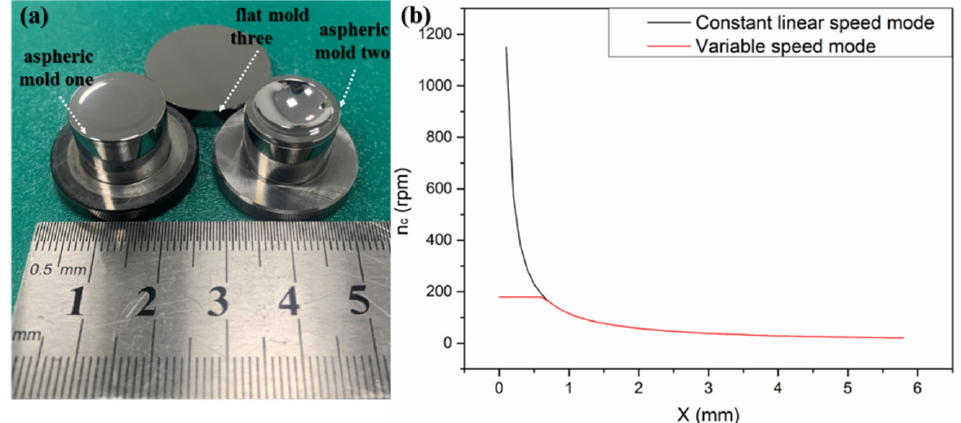
Figure 2. ( a ) Experimental mold; ( b ) Changes of the workpiece axis speed in the variable speed mode with the radius of the aspherical mold.